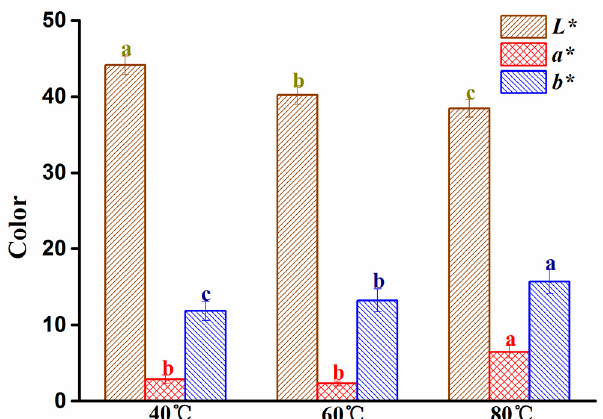
Figure 5. Effect of temperature on color parameters L* , a* , and b* . Different letters in the same color column indicate significant difference at p < 0.05.